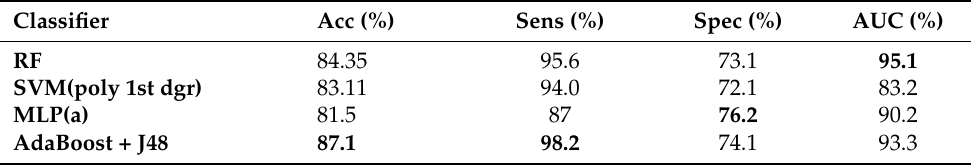
Table 8. The values of the classification performance parameters for texture analysis methods combined with conventional classifiers, obtained on combined CEUS and B-mode ultrasound